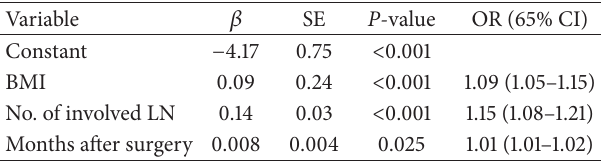
Table 3: Predictor factors of lymphedema.